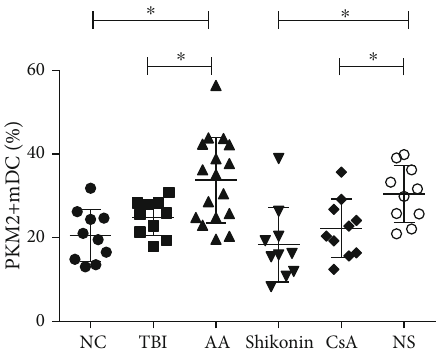
Figure 2: The PKM2+ mDC proportion of mDCs (PKM2+CD11c +/CD11c+) in the AA group was higher than those of the NC and TBI groups ( n = 10 , p < 0 : 05 ). There was no signi fi cant di ff erence between the NC and TBI groups ( n = 10 , p > 0 : 05 ). The PKM2 level is decreased in mDCs of the shikonin and CsA groups compared with the NS group ( n = 10 , p < 0 : 05 ). There was no signi fi cant di ff erence between the shikonin and CsA groups ( p > 0 : 05 ).